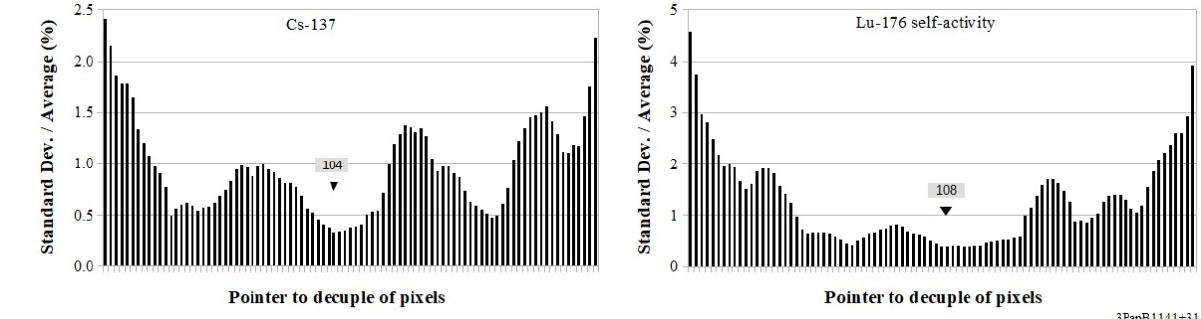
Figure A19. Plots of standard deviation to average ratios calculated for the decuples of adjacent net-charge pixel-values chosen along the entire set of 10 × 10 array of crystal-pixels, ordered by descending values for Cs-137 ( left ) and Lu-176 ( right ), respectively. The solid triangles show the pointers to the minimum values of the ratios corresponding to the decuple made by 104, 301, 305, 403, 405, 504, 505, 506, 510, 901 pixels for Cs-137, and by 108, 303, 305, 309, 502, 701, 702, 706, 810, 905 ones for Lu-176. The pixels are referred to by the RRCC notation.